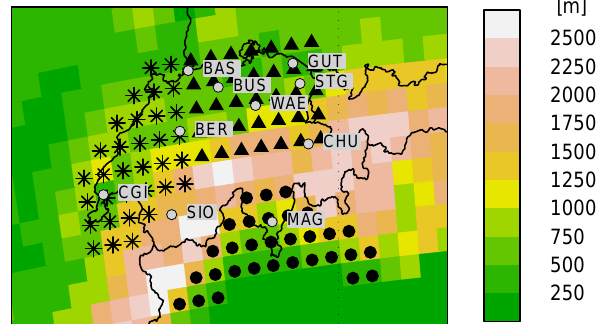
Fig. 1. Locations of the ten considered meteorological stations (gray dots, for the station names’ abbreviations, see Table 2), as well as RCM grid points (black symbols) used to define the three domains for the aggregated climate change signals (see Sect. 2.1): northeastern ( N , CHNE), western ( > , CHW) and southern ( • , CHS) Switzerland. Both are mapped onto a topography at roughly the RCMs’ spatial resolution. Note that CHNE combined with CHW is referred to as northern Switzerland in the text. Figure adapted from Fischer et al.